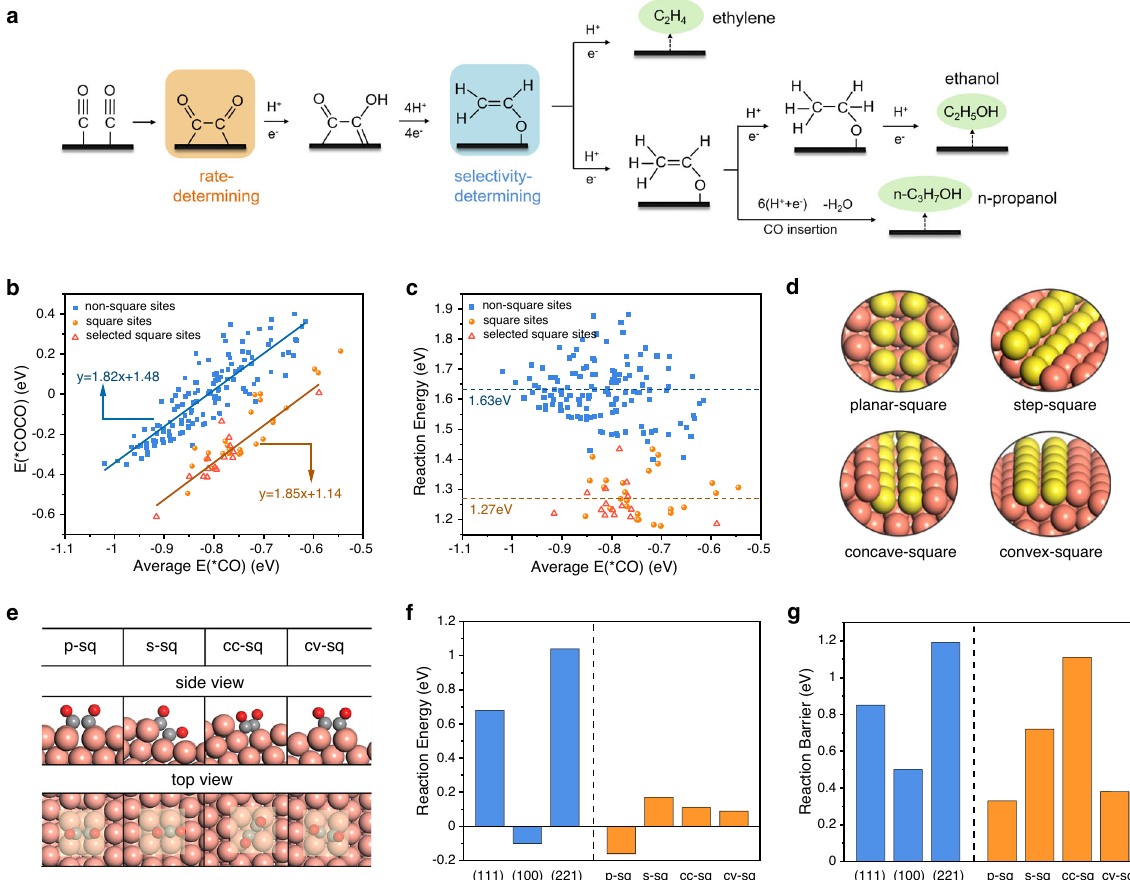
Fig. 2 Identi fi cation of C – C coupling active sites. a Reaction pathway for C 2 + products in CO2R. b The adsorption energy of *COCO as the function of the average adsorption energy of two adsorbed *CO. c Reaction energy (2*CO → *COCO) as the function of the average E(*CO) on these sites. d DFT periodic slab models of four square-like sites. e *OCCO con fi gurations on these four sites (solvent molecules have been removed to show the adsorbate con fi gurations). f Reaction energies and g barriers (2*CO → *COCO) on different DFT slab models under appropriate electrochemical interface. Color code: brown-Cu; yellow-Cu in square-like sites; gray-C;